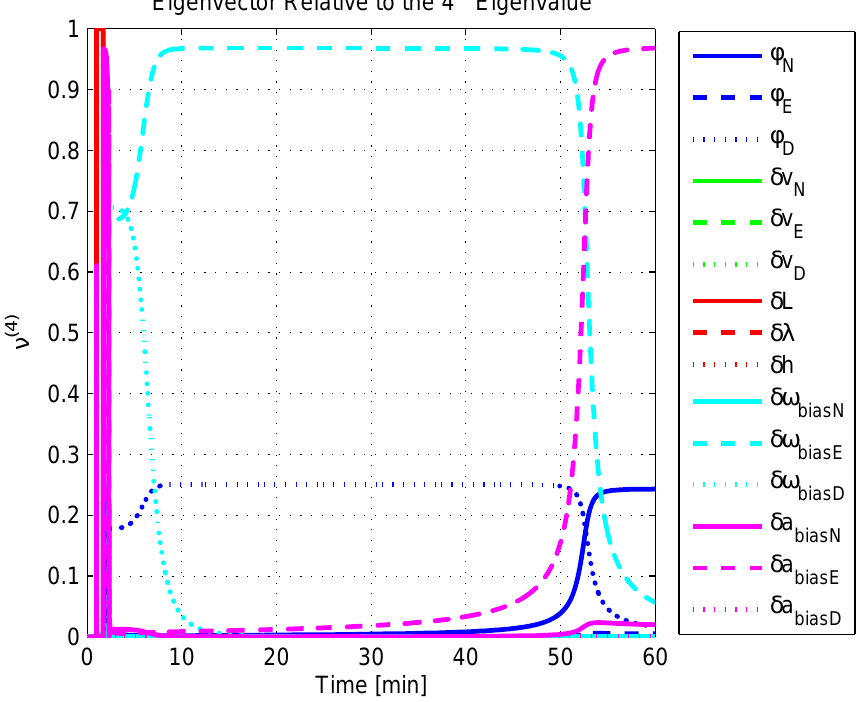
Figure 23. Eigenvector relative to the fourth eigenvalue in the repeated experimental test.